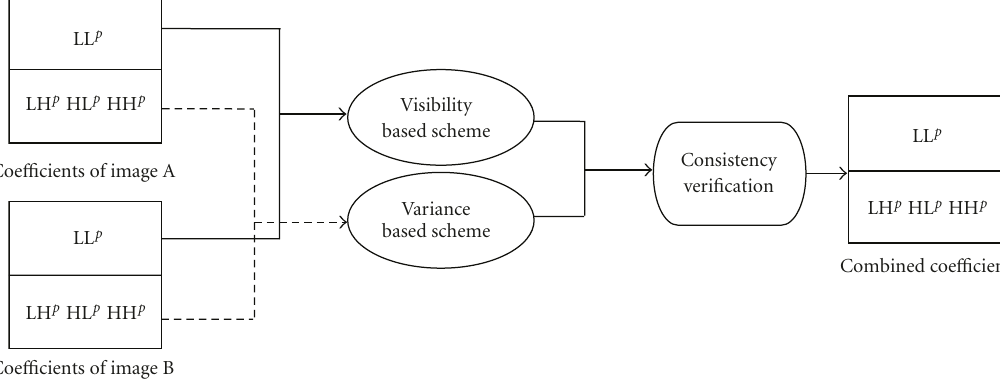
Figure 4: Schematic diagram of the proposed fusion